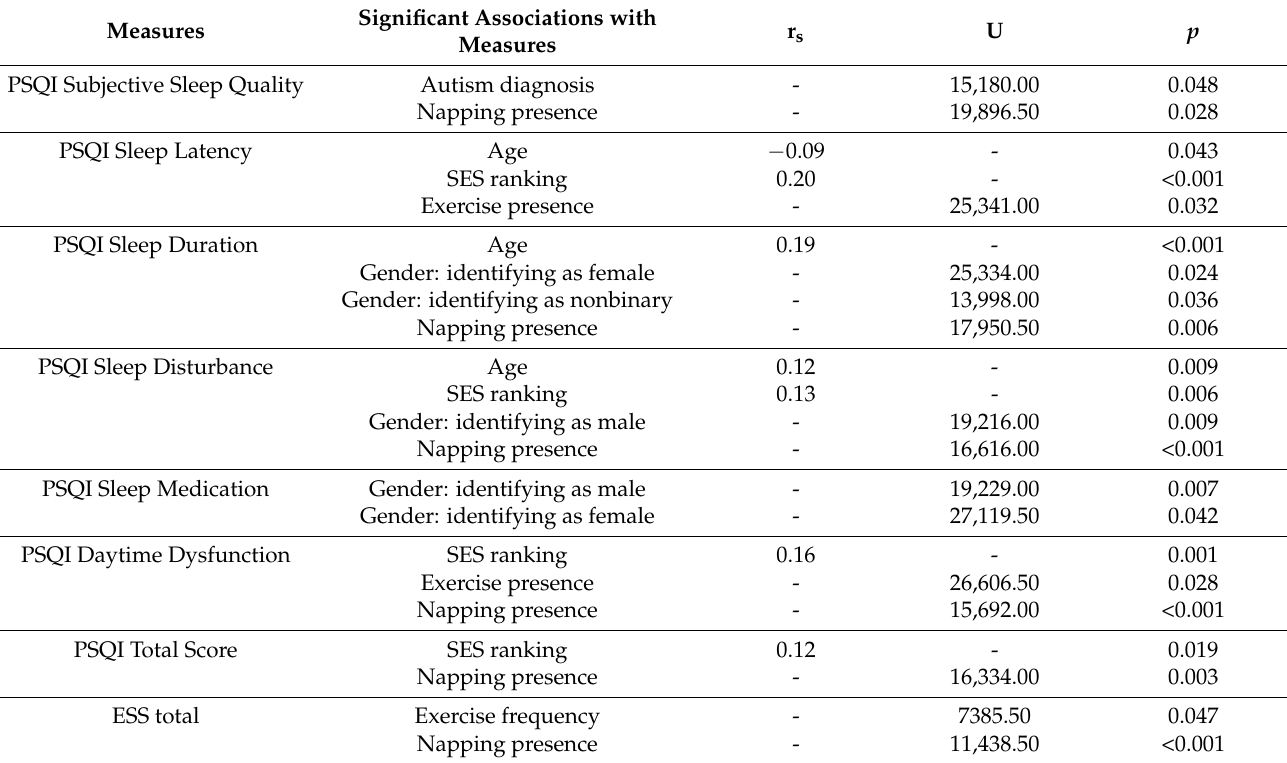
Higher scores indicate poorer sleep quality. HCP = healthcare professional. Table 4. Overview of significant associations between demographic and lifestyle variables and sleep quality measures. Significant Associations Measures